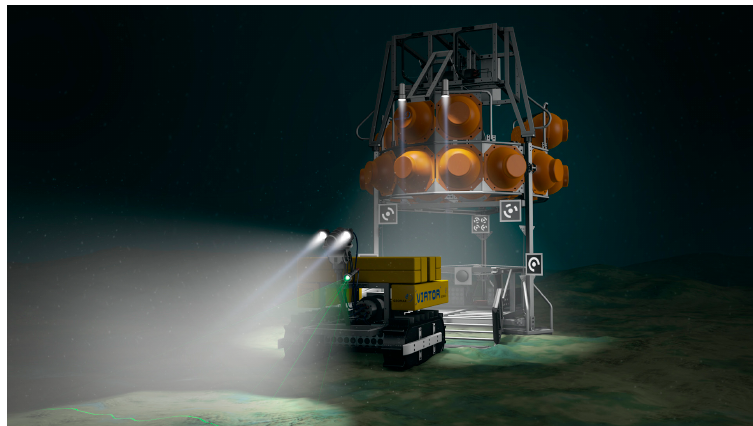
Figure 3. Autonomous seafloor vehicle: combination of central lander and mobile robot for operations of up to 6 km before the crawler returns to the central station to transfer the data and recharge it batteries (http://www.robex-allianz.de/en/). Source: Geomar; design: Meyer.